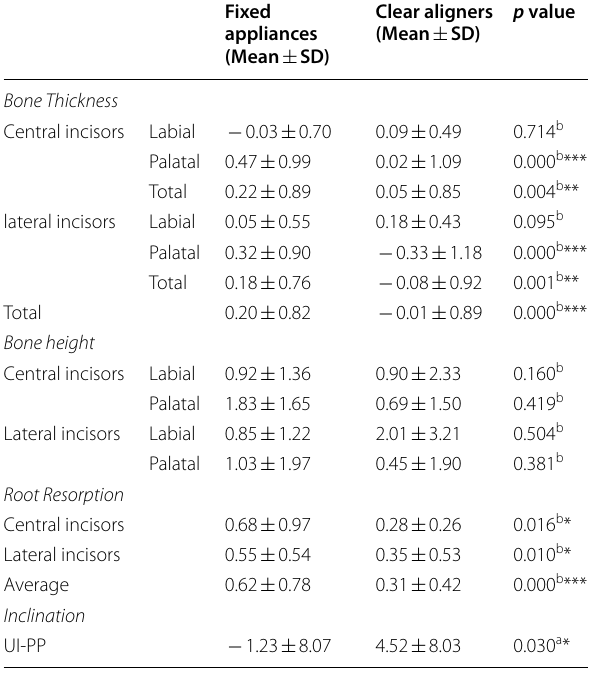
Table 4 Inter‑group comparison (T0‑T1) of the two studied groups